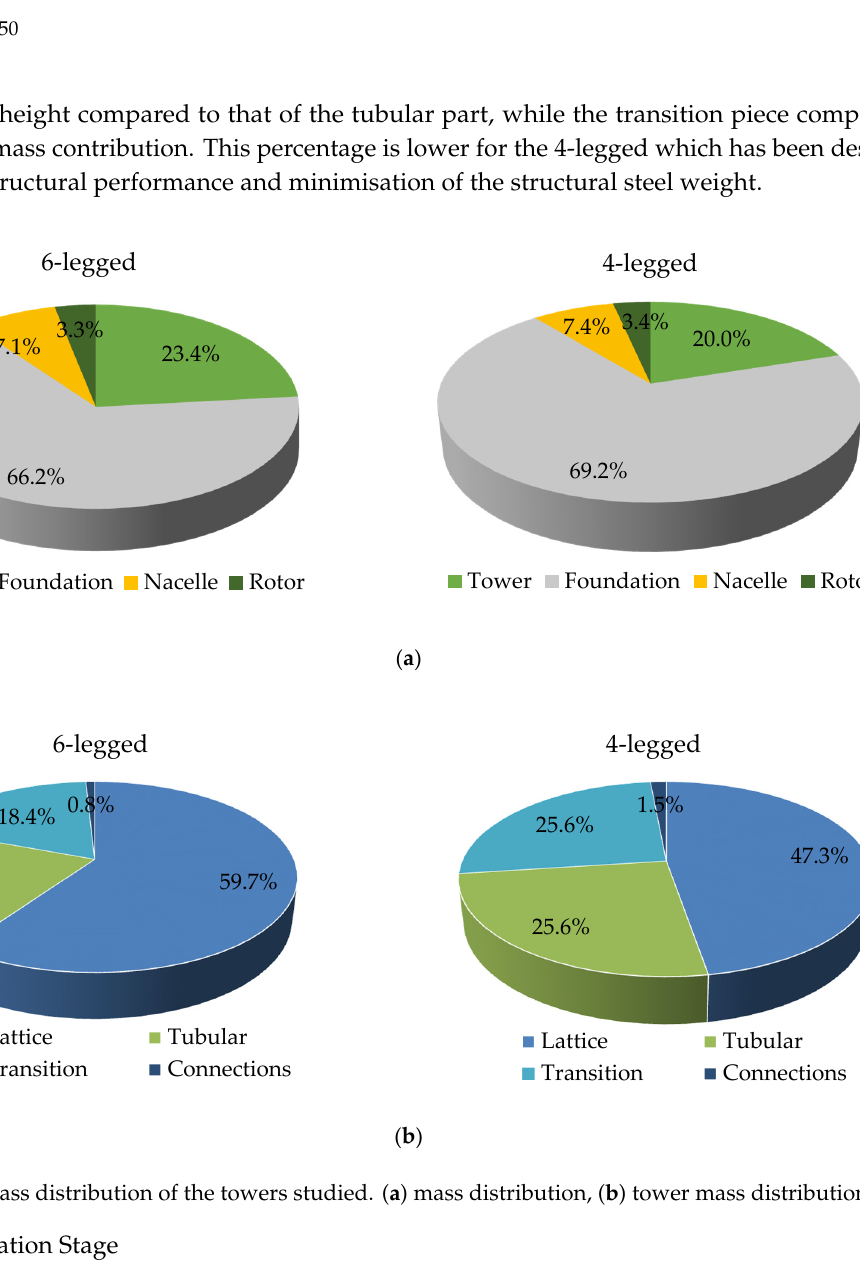
Table 3. Estimated number of trucks for 20 year life cycle.